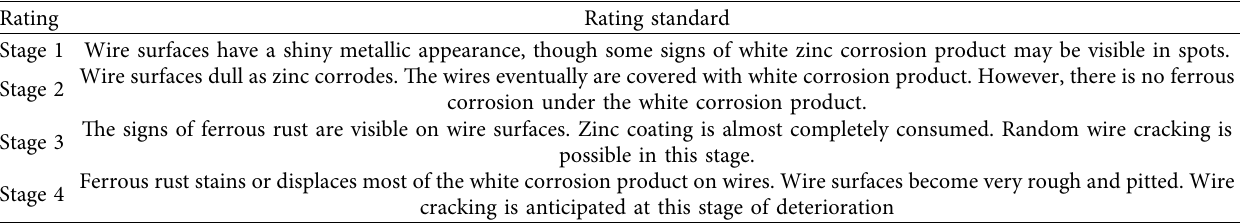
Table 6: Evaluation and rating system for corrosion on wire (Hopwood & Havens, 1984 [27]). Rating